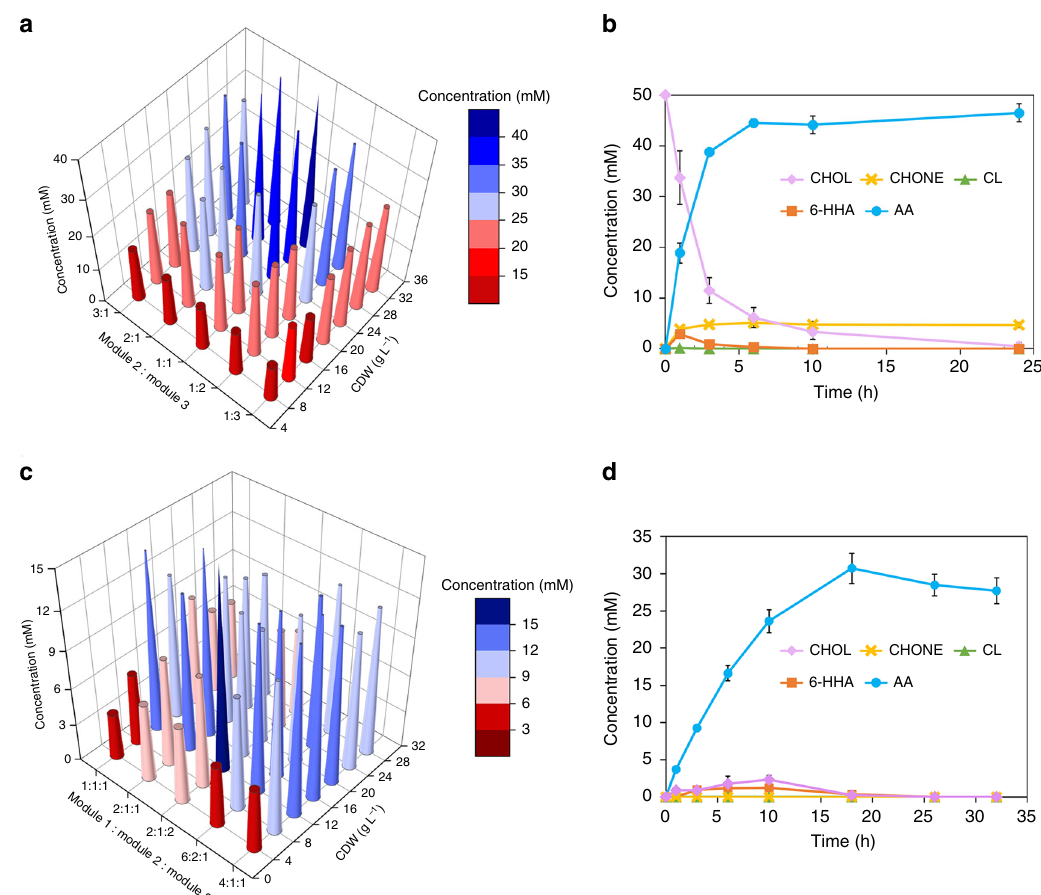
Fig. 6 Construction of E. coli consortia for the production of AA 7b. a Optimization of conditions for E. coli consortium 2_3 (EC2_3)-catalyzed conversion of CHOL 2b to AA 7b with a reaction time of 6 h. b Time course for EC2_3 catalyzed conversion of CHOL 2b to AA 7b under optimized conditions at 50 mM substrate. Blue line: AA; Orange line: 6-HHA; green line: CL; yellow line: CHONE; purple line: CHOL. c Optimization of conditions for E. coli consortium 1_2_3 (EC1_2_3)-catalyzed conversion of CH 1b to AA 7b with a reaction time of 6 h. d Time course for EC1_2_3-catalyzed conversion of CH 1b to AA 7b under optimized conditions at 100 mM substrate. Blue line: AA; Orange line: 6-HHA; green line: CL; yellow line: CHONE; purple line: CHOL. The data shown in a and c are presented as mean value of two biological replicates. The data shown in b and d are presented as mean value ± SD (standard deviations) of three biological replicates. Source data are provided as a Source Data fi